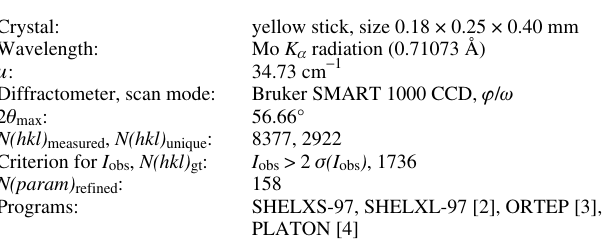
Table 1. Data collection and handling.